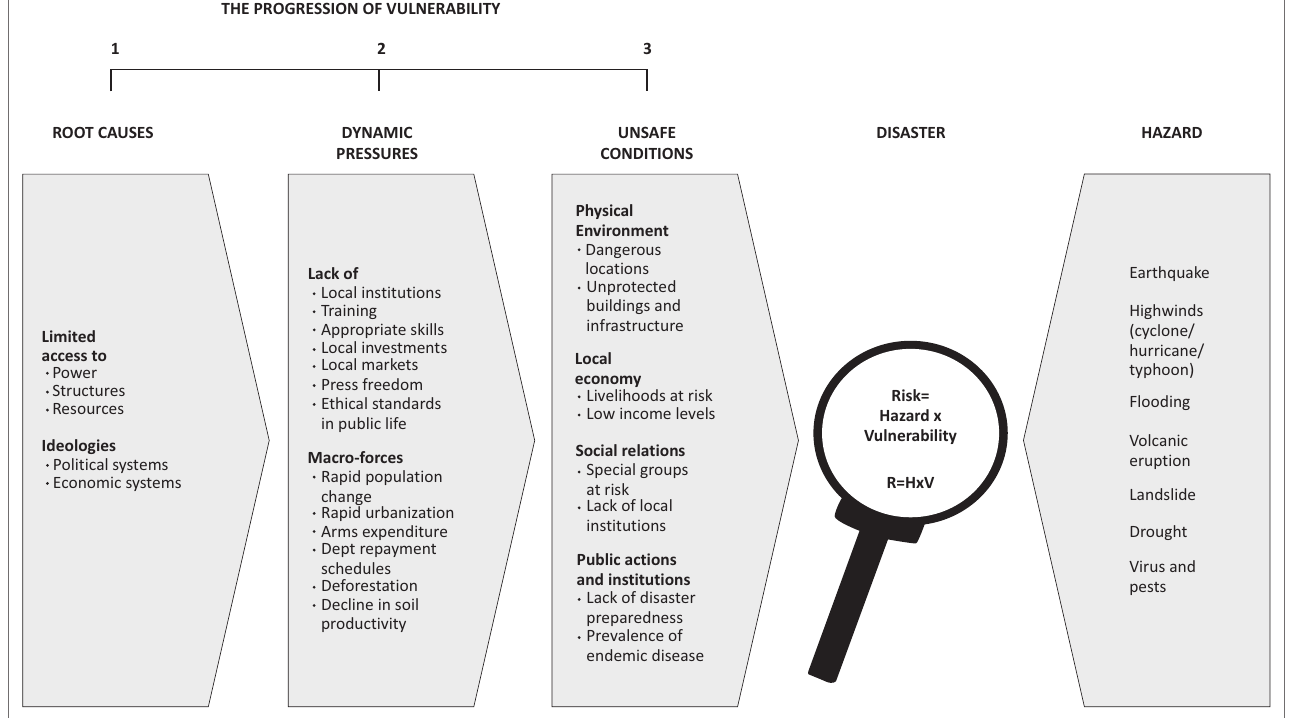
FIGURE 2: Pressure and release